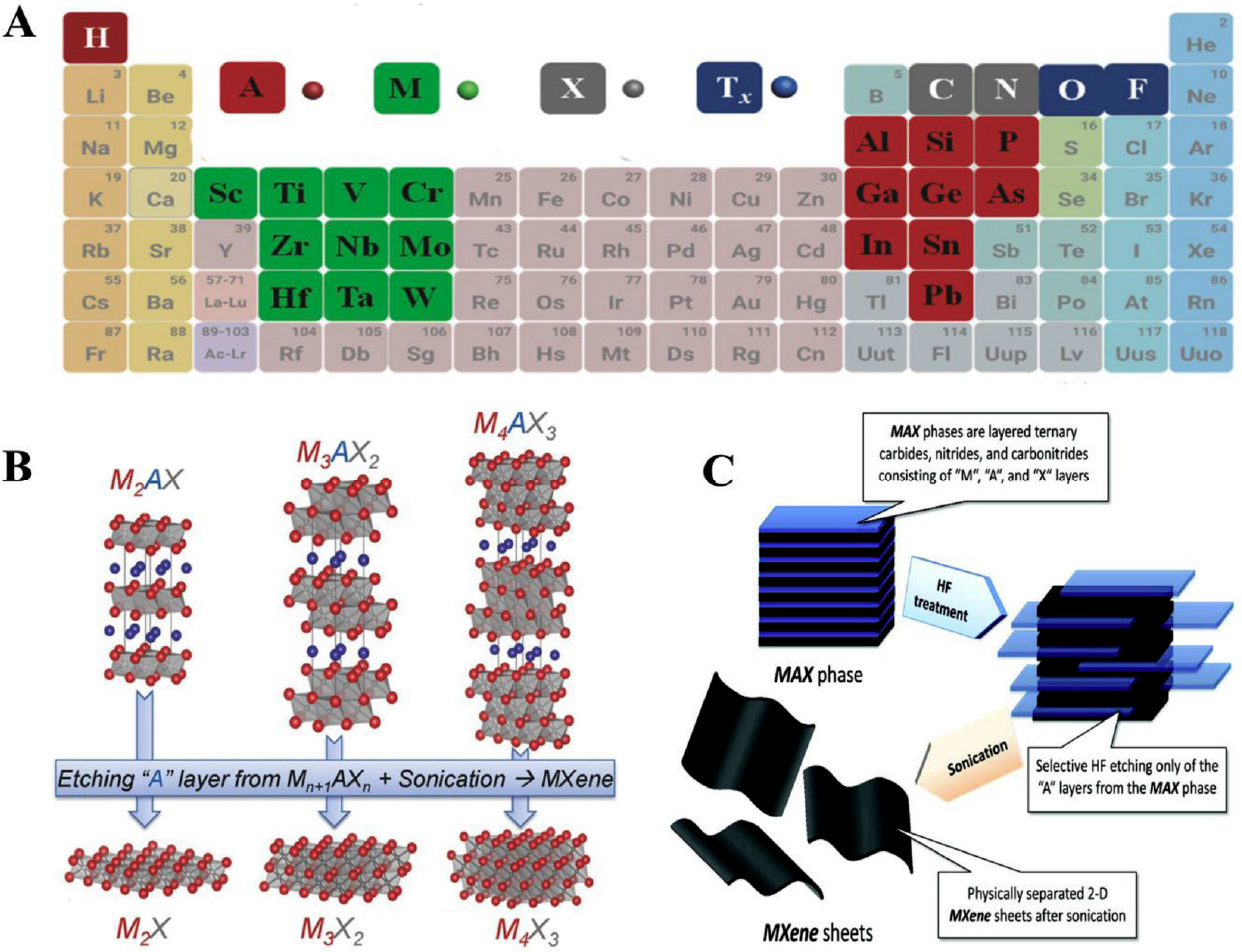
Figure 7. ( A ) A periodic classification demonstrating elements utilised for the MAX phases development ( B ) MAX phases employed for the synthesis of various MXenes ( C ) Synthesis of MXene sheets through exfoliation method. Reproduced from Ref. [95] with permission from Elsevier.